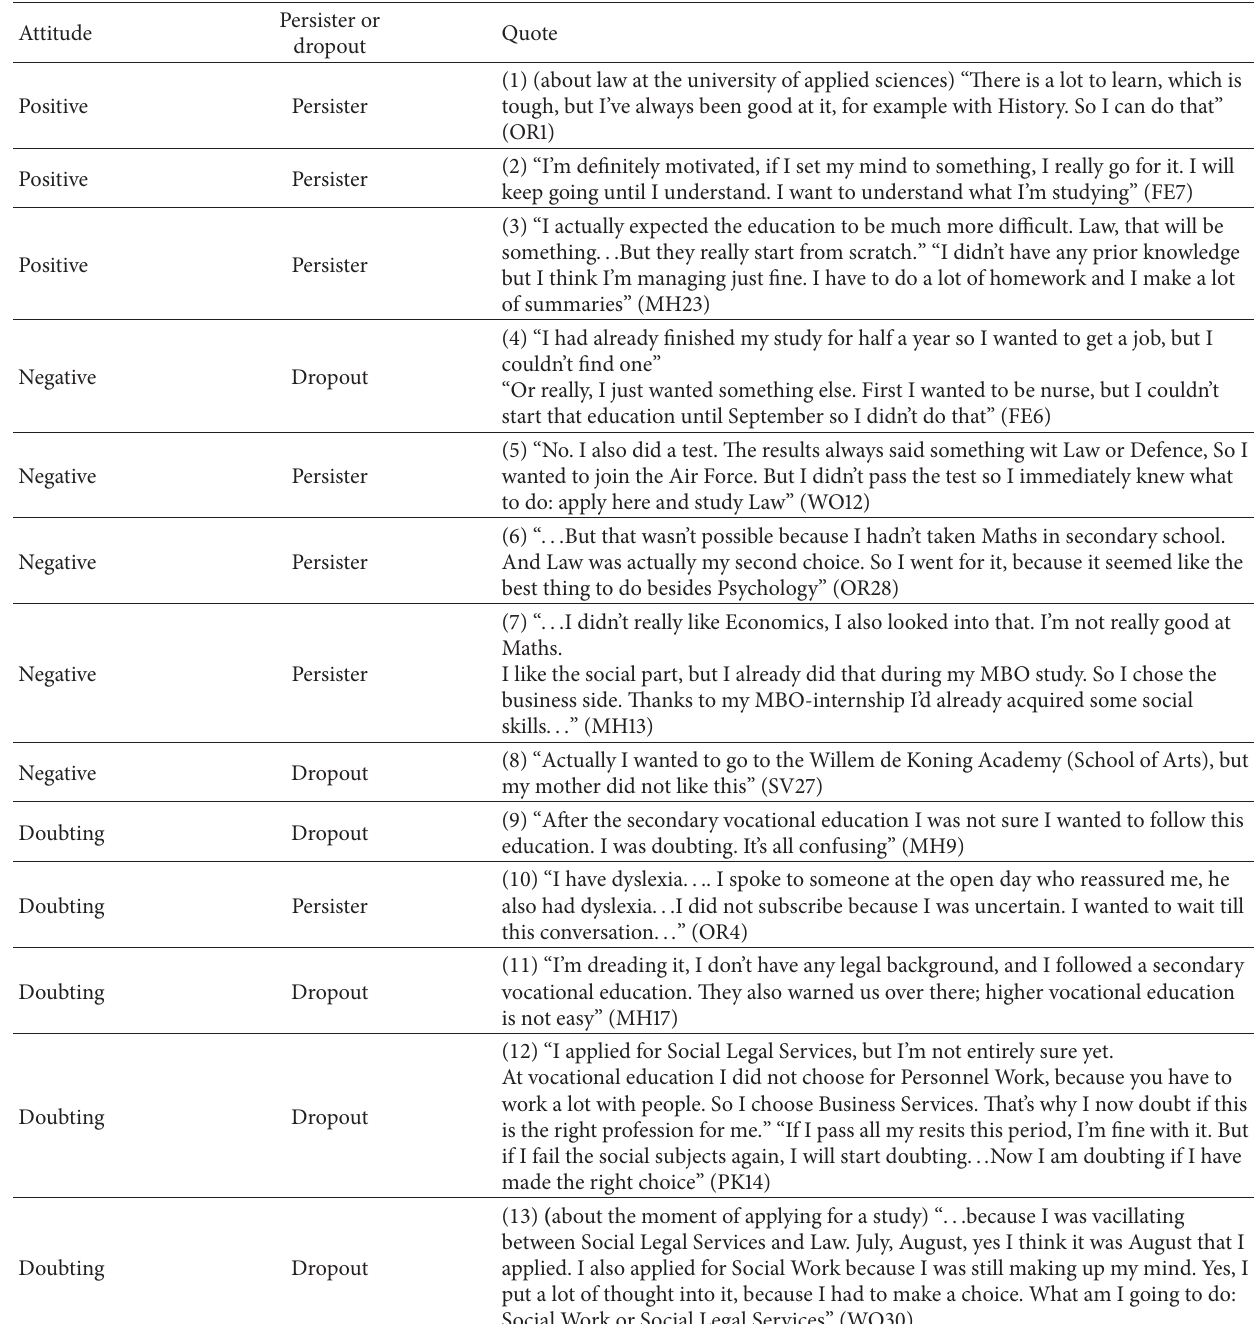
Table 8: Quotes that are illustrative for different